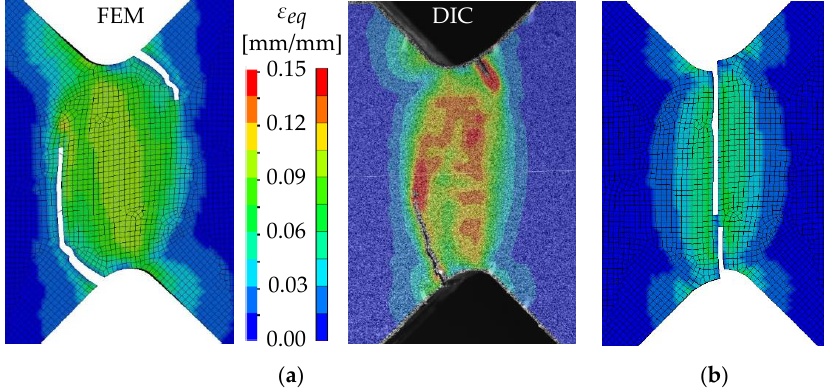
Figure 12. ( a ) Comparison of the fracture behavior of the FZ in shear tests and in numerical simulations with the calibrated BW criterion ( 𝜀 𝑓,𝑠 = 0.08) and ( b ) fracture behavior simulated with the BW criterion with 𝜀 𝑓,𝑠 = 0.07.